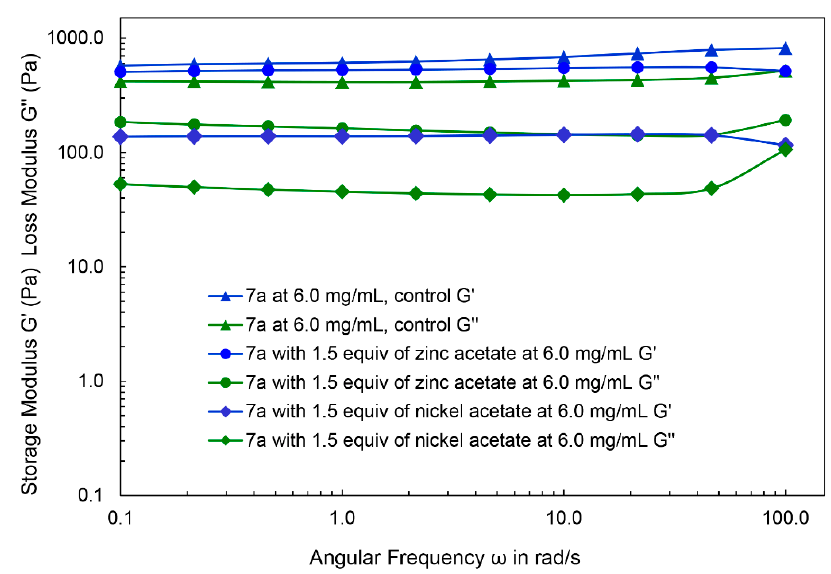
Figure 9. The rheological properties of the gels formed by compound 7a and its metallogels in DMSO:H 2 O (1:5), obtained at 1% strain. The concentrations are 6.0 mg/mL for 7a in all three.